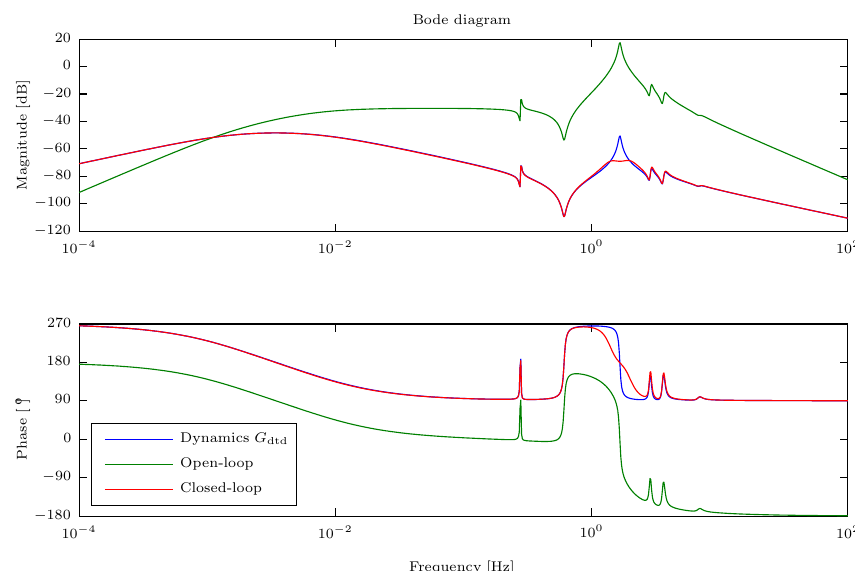
Figure 7. Bode diagrams of the drivetrain dynamics, the open-loop (controller times drivetrain dynamics), and the closed-loop